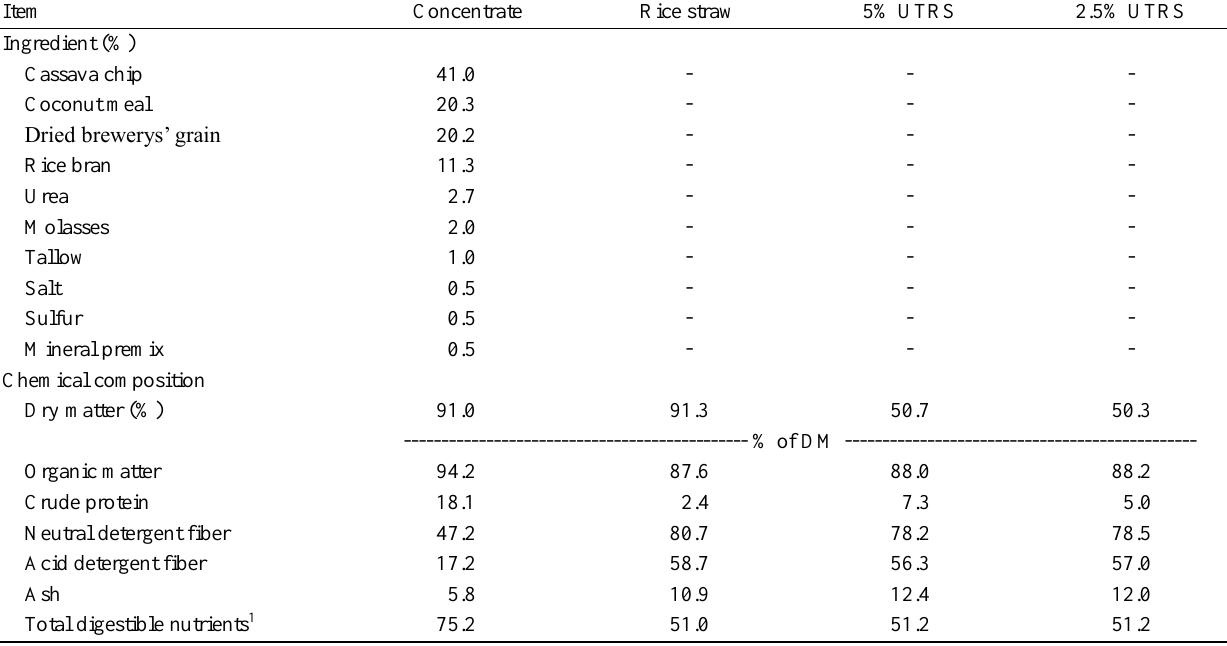
Table 1. Ingredients and chemical compositions of concentrate, rice straw and urea-treated rice straw (UTRS) used in the